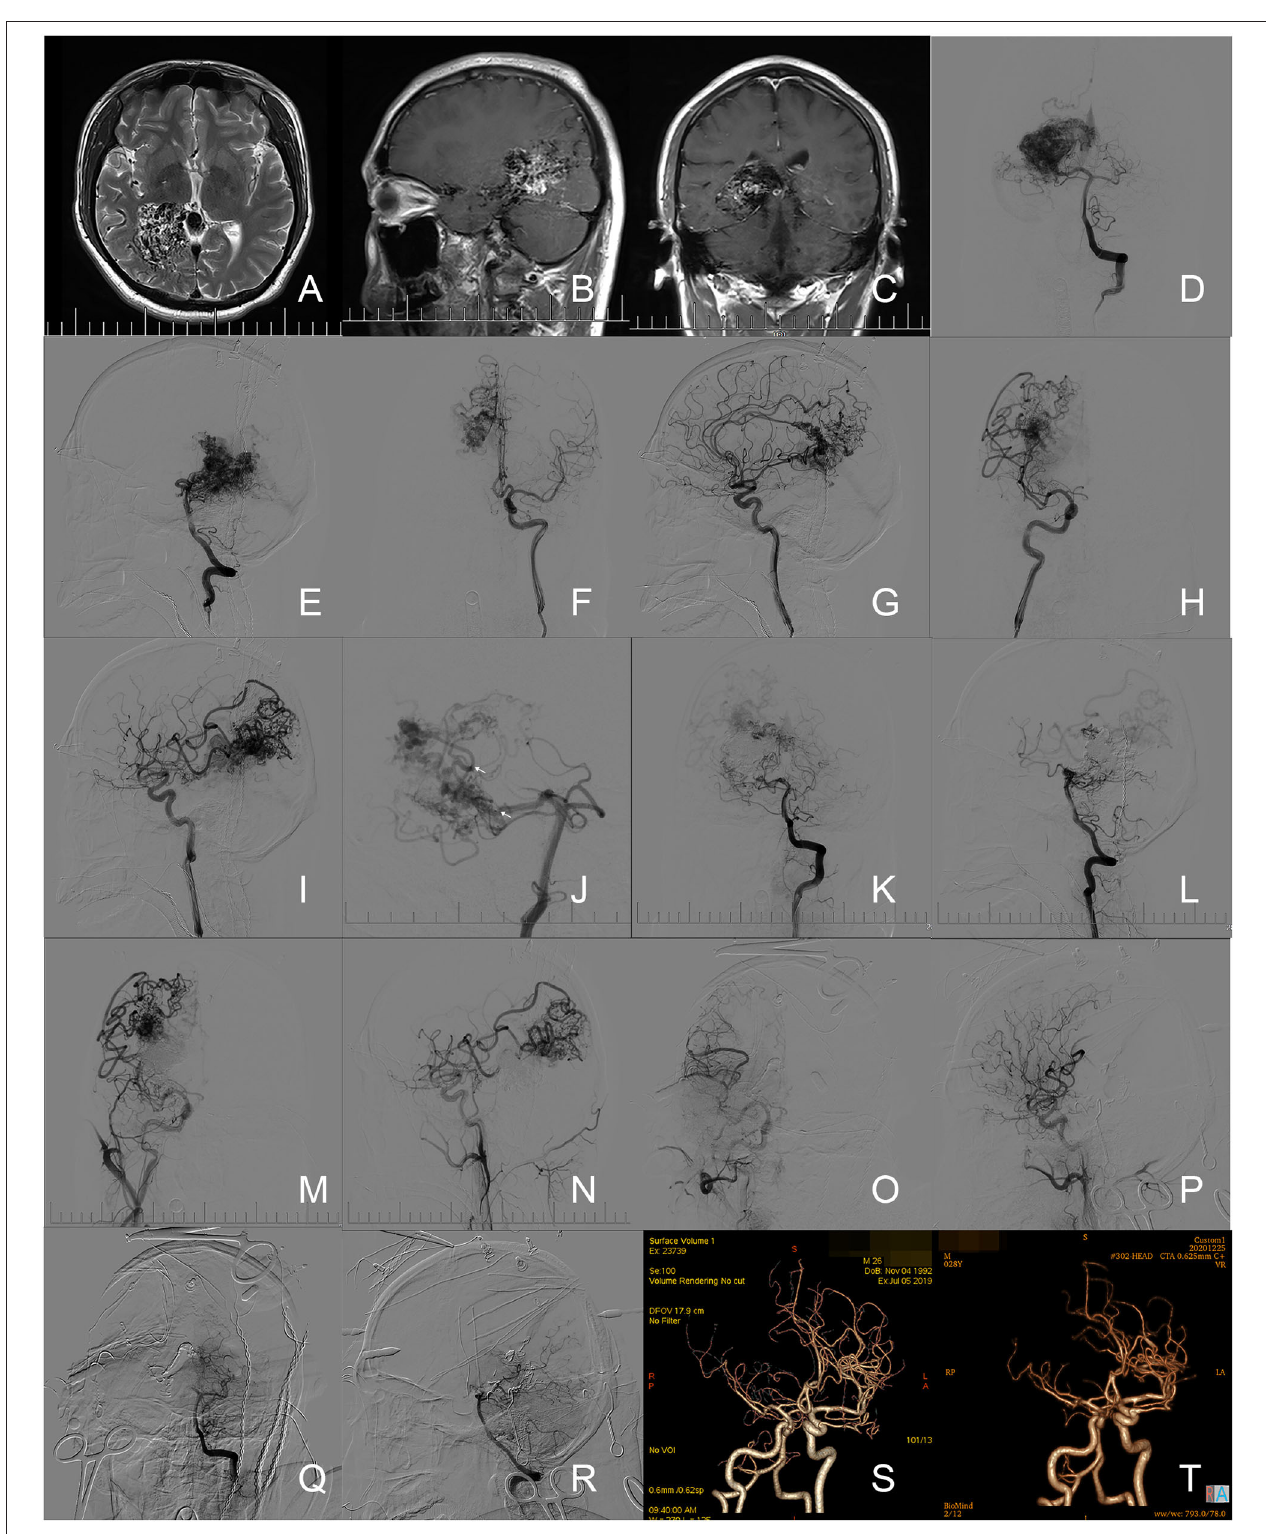
FIGURE 2 | Illustration of case 11. (A–C) Preoperative axial T2-weighted image, sagittal, and coronary enhanced T1-weighted image of MR revealed the bAVM located in the right tempo-parietal-occipital lobe. (D,E) Angiograms via the left vertical artery revealed the feeders from the right posterior cerebral artery (PCA) and the drainage through Galen’s vein. (F,G) Angiograms from the left ICA demonstrated the feeders from the right callosomarginal artery and precuneal artery. (H,I)